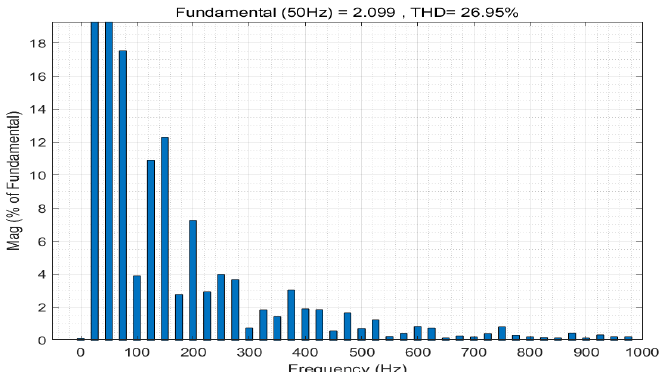
Figure 6. Spectrogram of supply current after access to APF at 0 s.